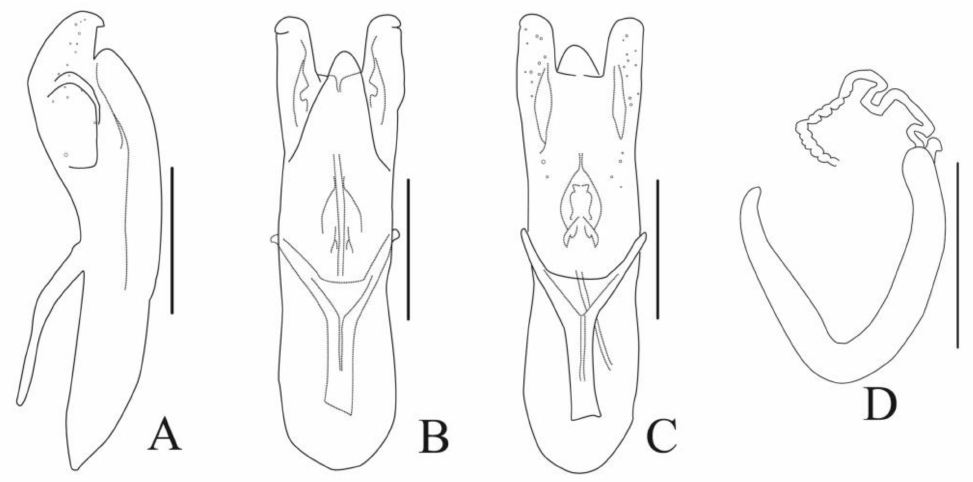
Figure 12. Cryptocephalus ( Burlinius ) bilineatus (Linnaeus, 1767): ( A ) lateral view of aedeagus; ( B )